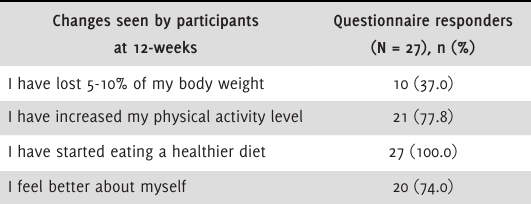
Table 3. Changes Noticed by Participants After Completion of the 12 Week